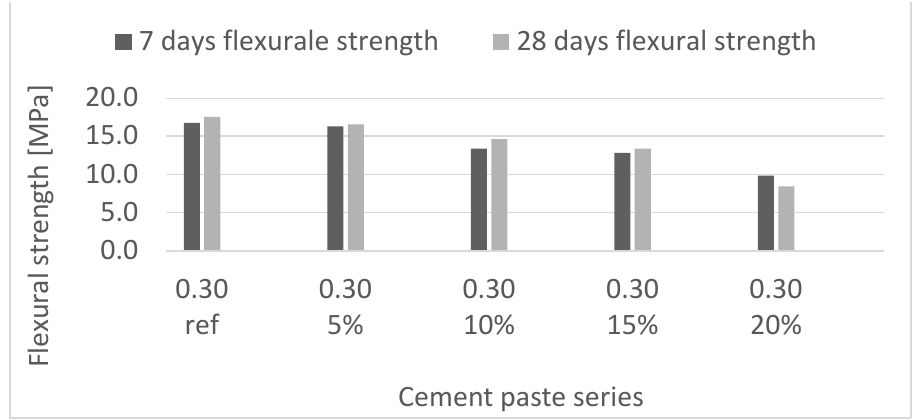
Figure 4. Effects of cement substitution with a spent FCC catalyst on the 7- and 28-day flexural strength of cement paste samples.